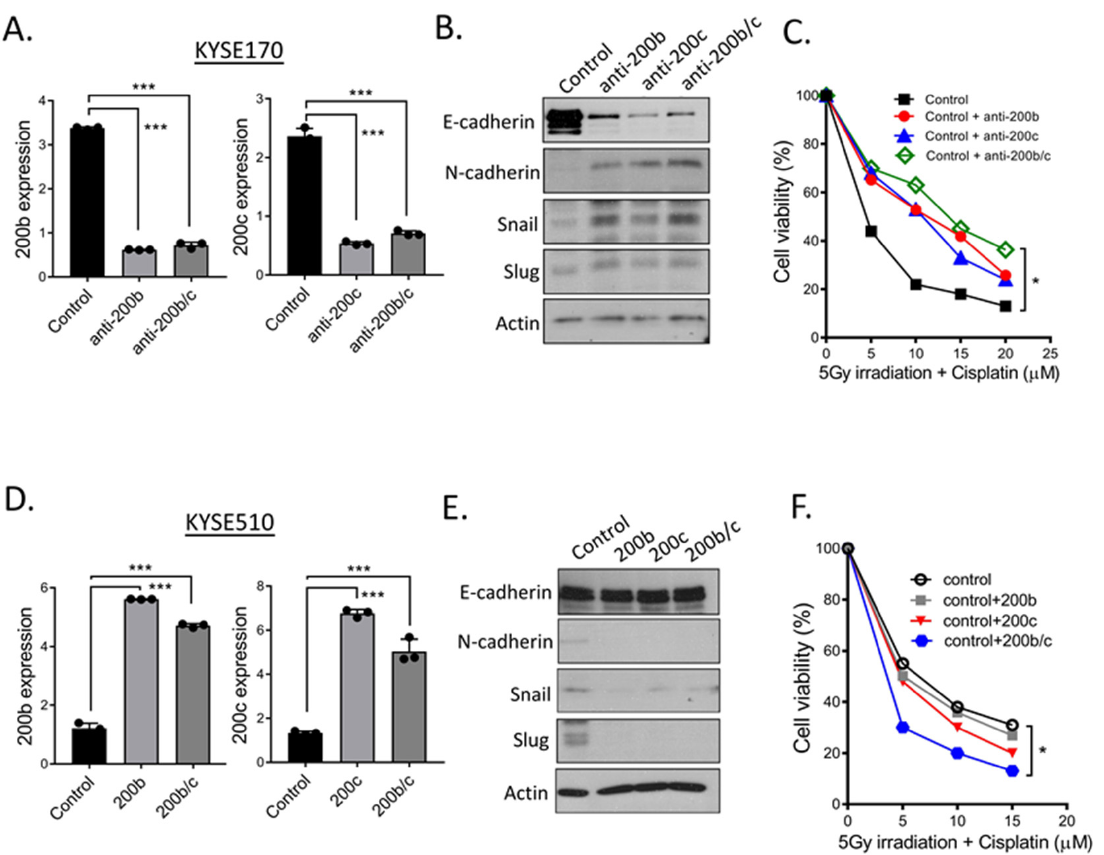
Figure 4. Manipulating miR-200b and miR-200c expressions in Kyse170 and Kyse510 cells alter cell epithelial–mesenchymal feature and modulate cell sensitivity to CCRT treatment. ( A ) miR-200b and miR-200c levels were manipulated by anti-miR-200b and miR-200c oligonucleotides transfection in Kyse170 cells, the reduction of miR-200b and miR-200c expressions were confirmed by qRT-PCR analysis. ( B ) Examination of E-cadherin, N-cadherin, snail, and slug expressions in anti-miR-200b, miR-200c, and miR-200b/c oligonucleotides-transfected Kyse170 cells. Total cell lysates were collected and subjected to Western blot using indicated antibodies (anti-E-cadherin, N-cadherin, snail, and slug). β -actin was determined as loading control. ( C ) miR-200b and miR-200c suppression modulate Kyse170 cells resisting to CCRT treatment. Control and anti-miR-200b, anti-miR-200c, or anti-miR-200b/c oligonucleotides-transfected Kyse170 cells were plated into a 96-well plate, treated with 5 Gy radiation and at the indicated concentrations of cisplatin (0, 5, 10, 20, 30, 40, 50, and 100 µ M). After 48h incubation, cell viability was determined by MTT assay. Relative percentage of viable cells compared to cells without CCRT treatment were shown. ( D ) Kyse510 parental cells were transfected with control, miR-200b, miR-200c and miR-200b/c precursors, respectively. qRT-PCR analysis was used to confirm ectopic miR-200b, miR-200c and miR-200b/c expressions in Kyse510 parental cells. ( E ) Total cell lysates of transfected Kyse510 parental cells from ( D ) were collected and subjected to Western blot using indicated antibodies (anti-E-cadherin, N-cadherin, snail, and slug). β -actin was used as loading control. ( F ) Control and miR-200b, miR-200c or miR-200b/c precursors-transfected Kyse510 were subjected to MTT assay to examine the effect of CCRT treatment on their cell viability. Treatment conditions were described as in ( C ). Relative percentage of viable cells compared to cells without CCRT treatment were shown. * p < 0.05, *** p <